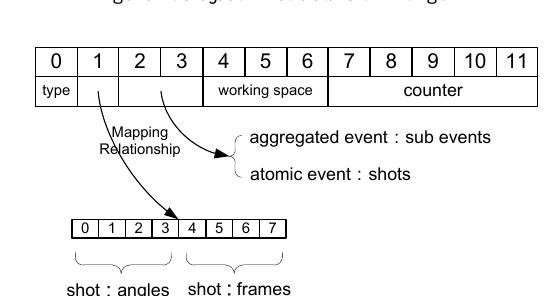
Figure 2. Object ID structure of MongoDB